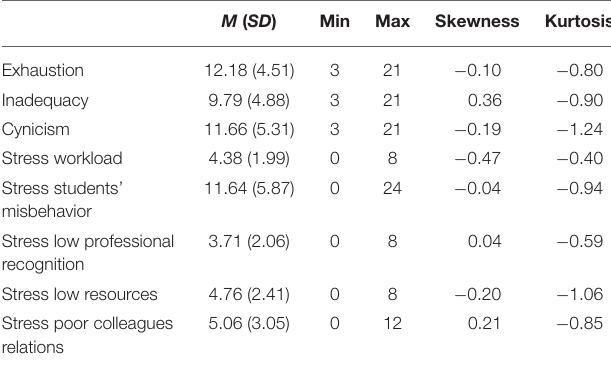
TABLE 2 | Profile indicators and predictors of profile